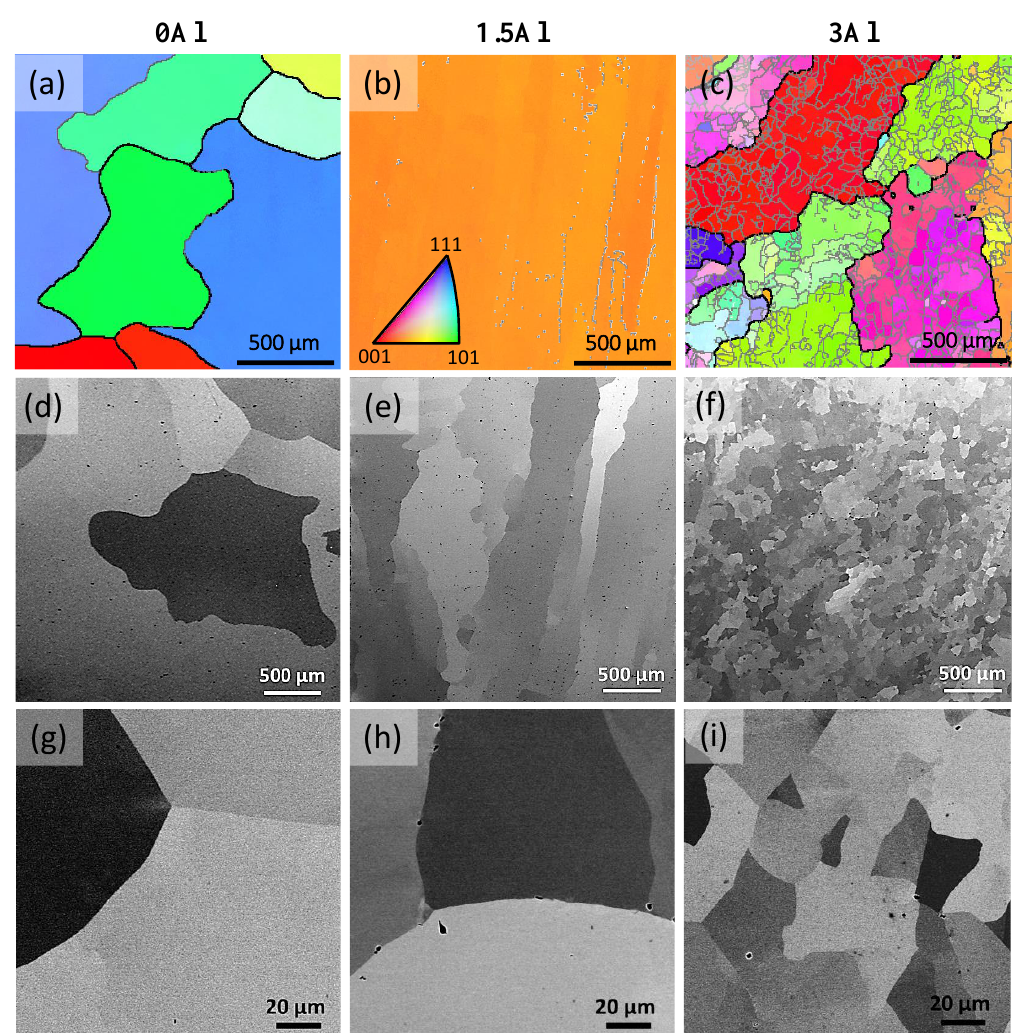
Figure 6. EBSD IPF maps ( a – c ), and SEM micrographs ( d – i ) for the austenitic steels in the homoge- nized condition; ( a , d , g ) 0Al, ( b , e , h ) 1.5Al and ( c , f , i ) 3Al steels. Black and gray lines superimposed on IPF maps indicate HAGBs and LAGBs, respectively. HAGBs and LAGBs refer to boundaries with misorientation angles above 15° and in the range of 1 – 15°, respectively. The lower threshold for LAGBs was reduced to 0.5° for the 1.5Al steel.